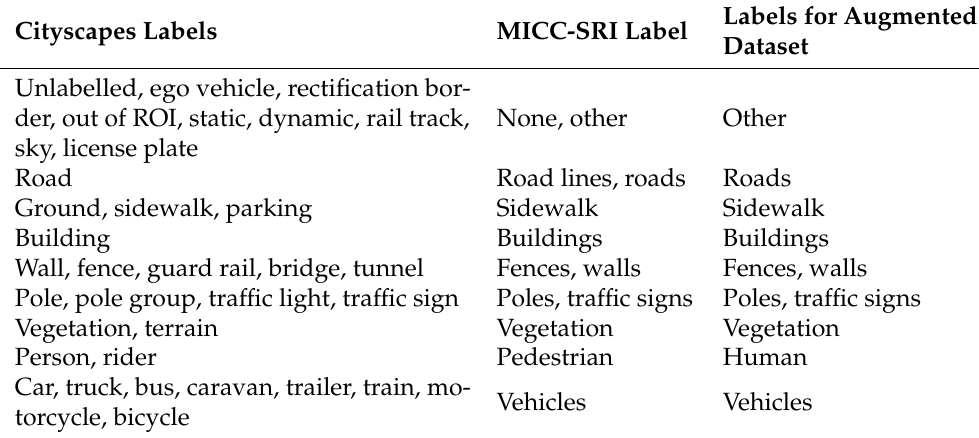
Table 1. Labelling for experiments with MICC-SRI dataset.